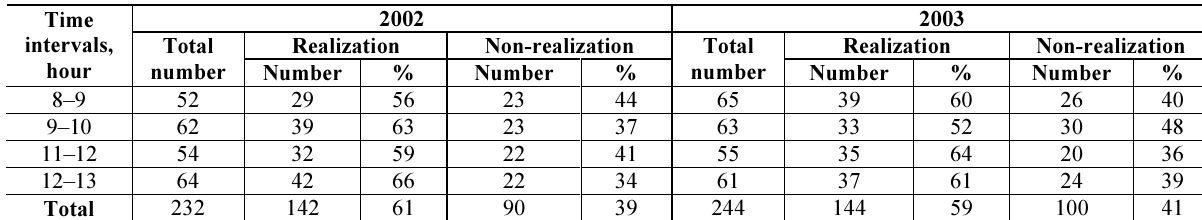
Table 3. Efficiency of prognostic connection of HCRF decrease between two adjacent days at an interval 1.2–1.6 MeV